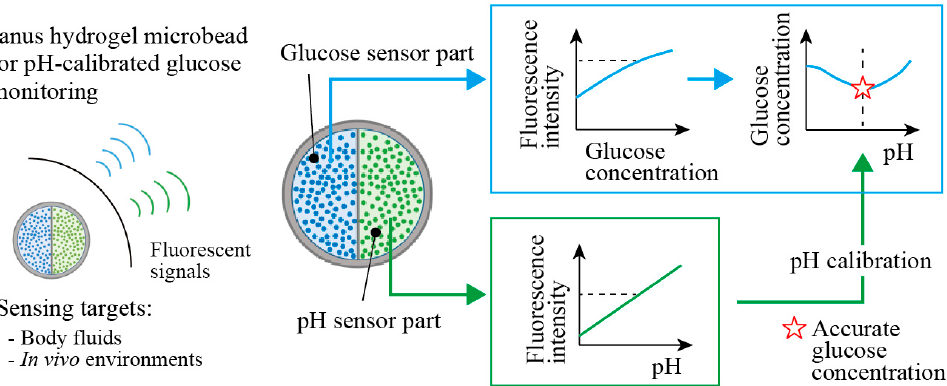
Figure 1. Conceptual illustration of Janus hydrogel microbeads for sensing glucose concentration with pH calibration. The microbeads are composed of fluorescent glucose sensor and pH sensor in each hemisphere. The fluorescence intensity of the glucose sensor part provides accurate glucose concentration readings, with calibration by the surrounding pH obtained from the fluorescence intensity of the pH sensor part.